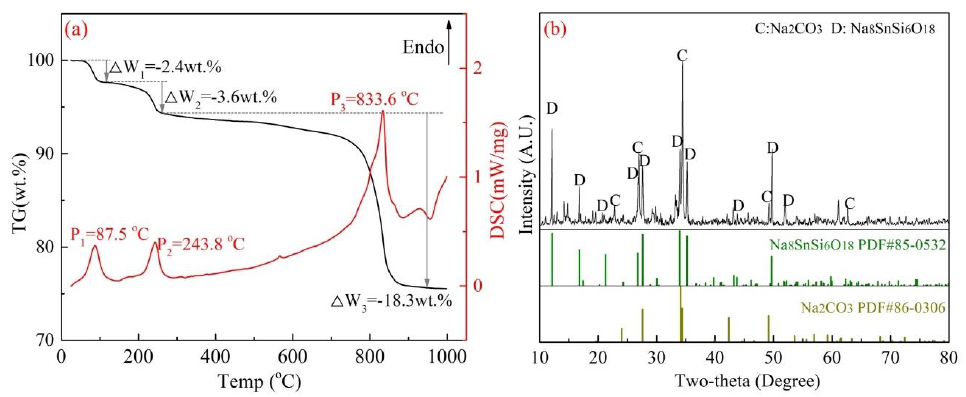
Figure 7. Reactions between Na 2 SnO 3 ·3H 2 O and SiO 2 (( a )-TG-DSC analysis, ( b )-XRD analysis of the TG products).